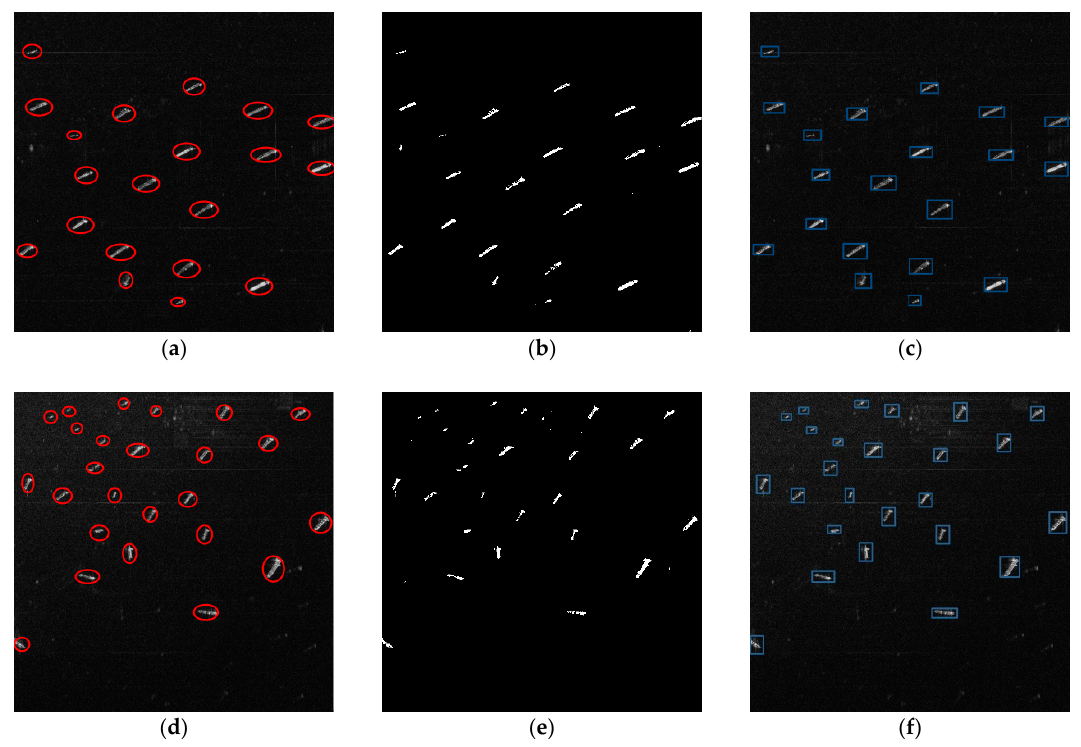
Figure 12. Results of the method on TerraSAR-X images. ( a ) The sub-image #4 from TerraSAR-X image; ( b ) The binary indication image of sub-image #4; ( c ) Result of sub-image #4; ( d ) The sub-image #5 from TerraSAR-X image; ( e ) The binary indication image of sub-image #5; ( f ) Result of sub-image #5.